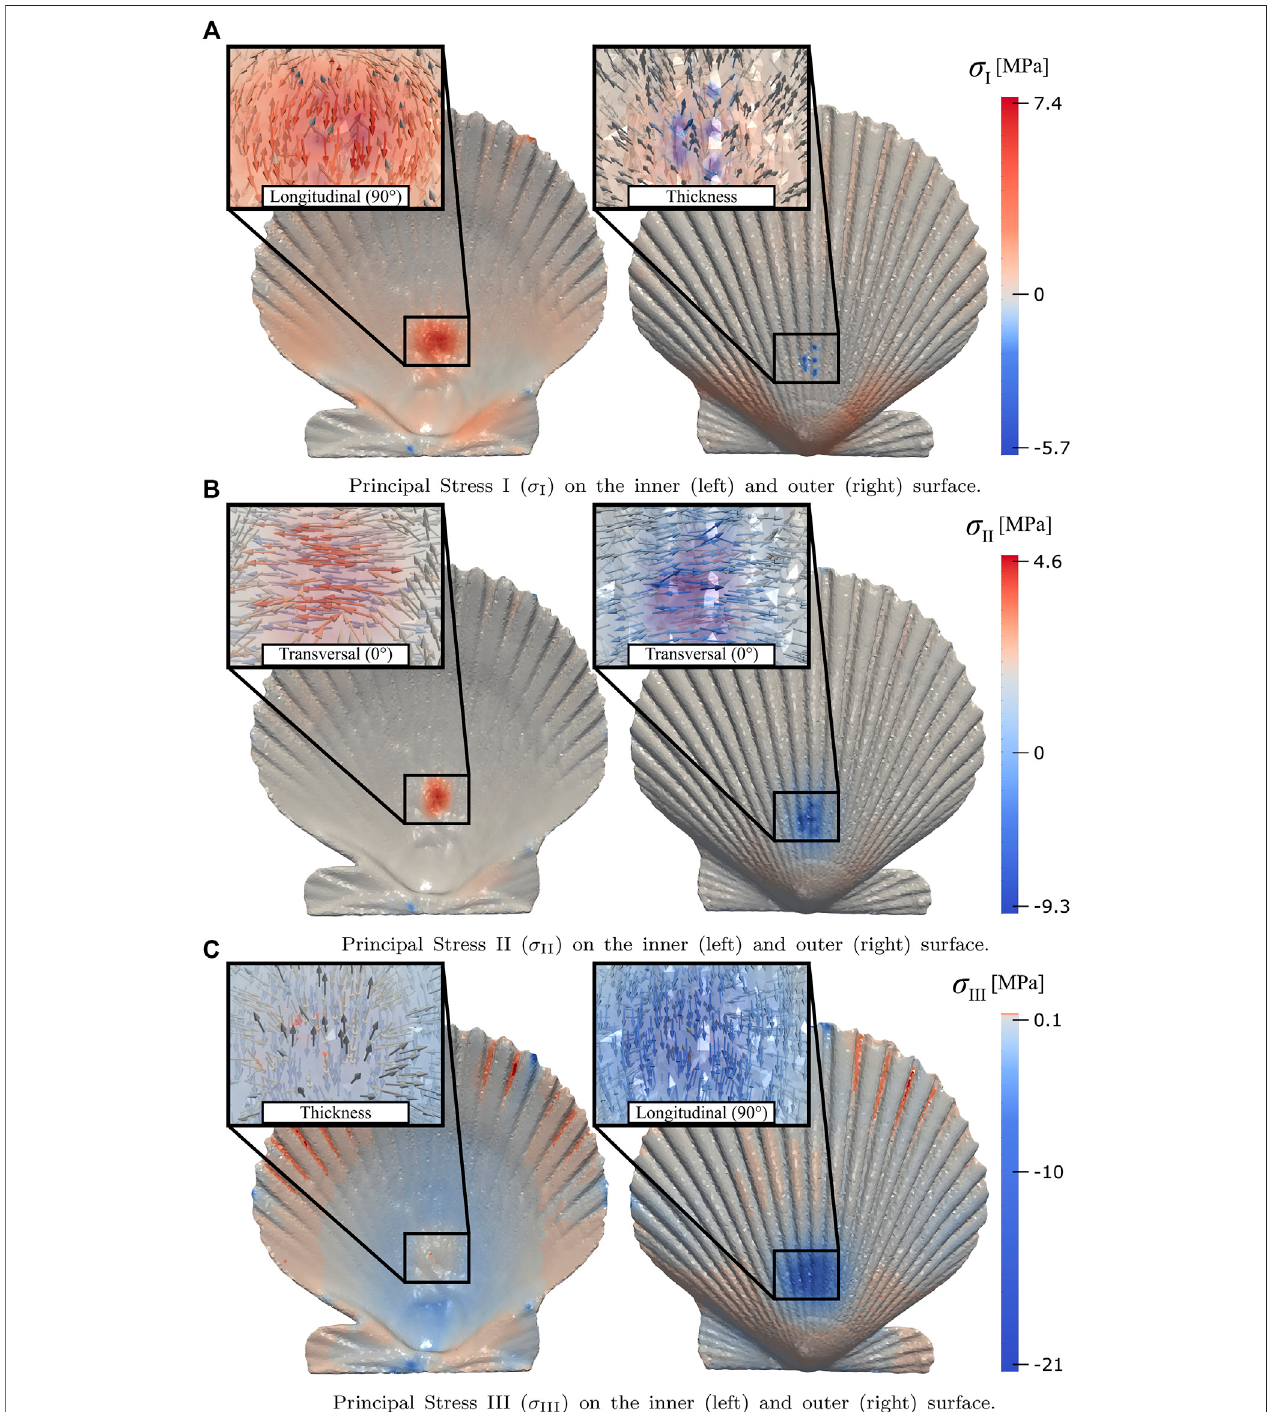
FIGURE 9 | Principal stresses magnitude and directions (in the boxes) in the shell-punch contact area: (A – C) show the principal σ I , σ II , and σ III on the inner (left) and outer (right) surface, respectively.